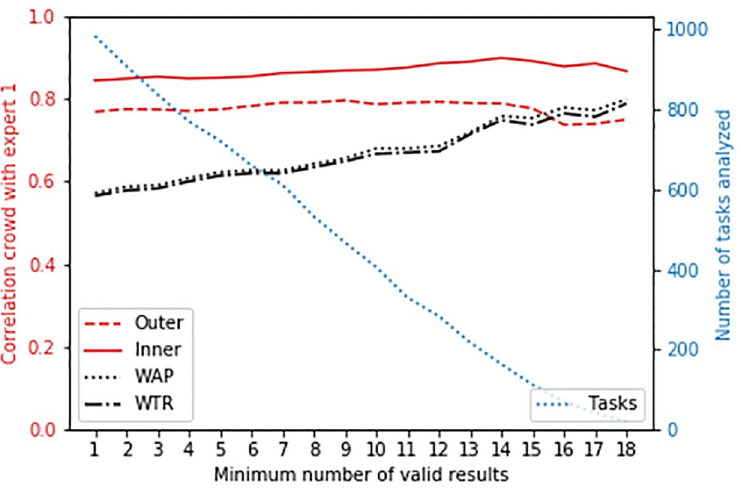
Fig 9. Correlation of all four measures between the expert and crowd (median combining), for tasks with at least a specific number of valid results.